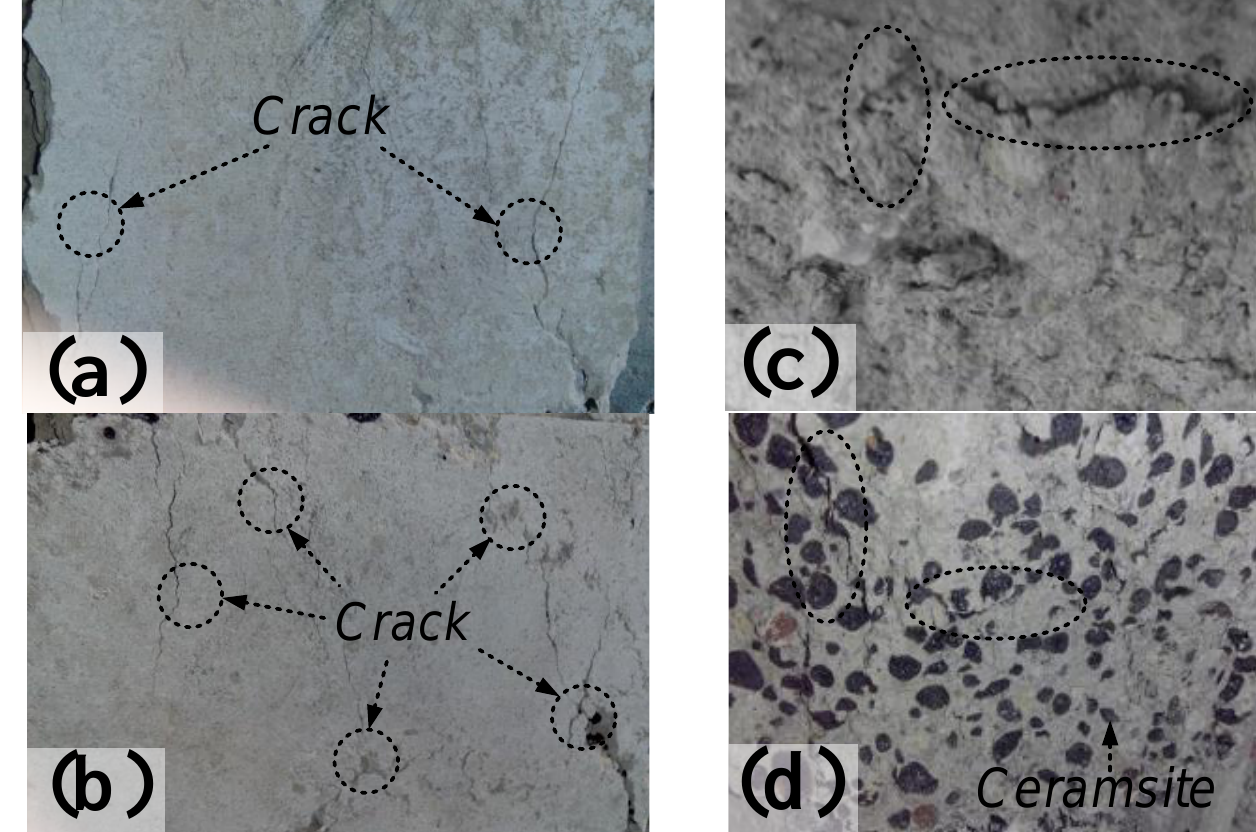
Figure 6. The failure mode of the NCRPB sample without FAC ( a , c ) and with FAC ( b , d ).